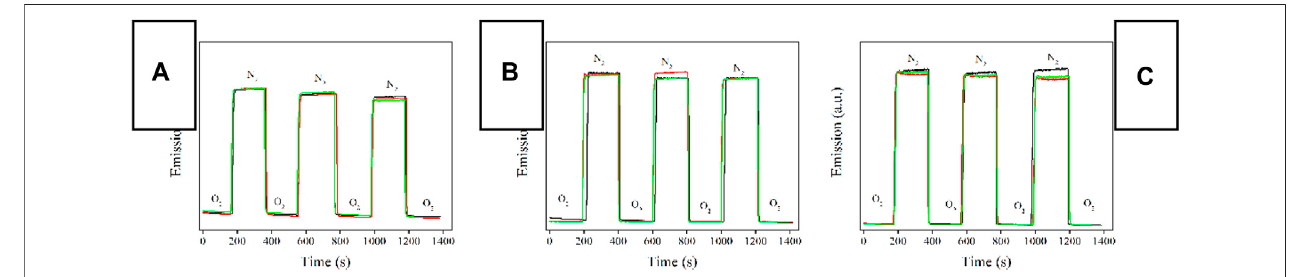
FIGURE 8 | Emission intensity monitoring of Ru-n@PS fi bers upon surrounding atmosphere periodically switched between pure N 2 and pure O 2 . Blank means 10%, red means 12%, and green means 15%. (A) Ru-1@PS, (B) Ru-2@PS, and (C) Ru-3@PS.